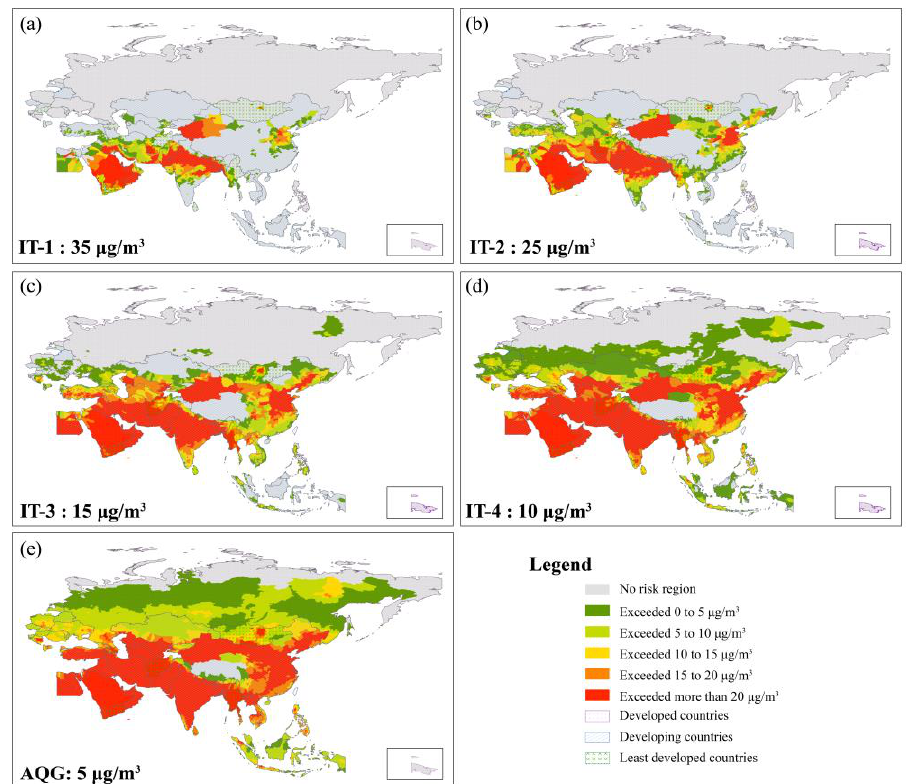
Figure 9. Key regions under different target of WHO Air Quality Guidelines. ( a ) IT-1 (35 μg/m 3 ), ( b ) IT-2 (25 μg/m 3 ), ( c ) IT-3 (15 μg/m 3 ), ( d ) IT-4 (10 μg/m 3 ), ( e ) AQG (5 μg/m 3 ).